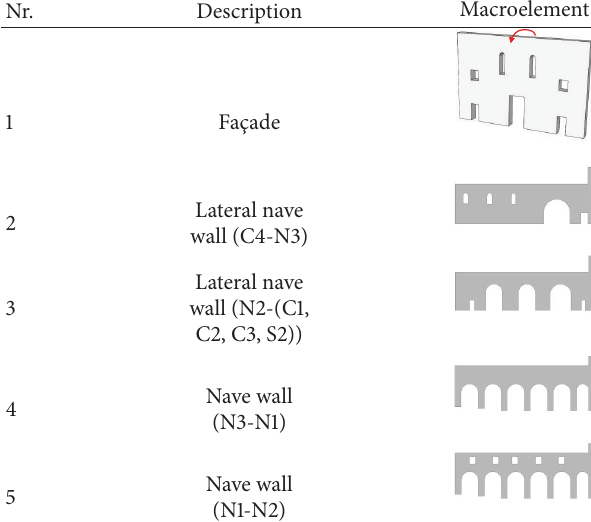
Table 2: Main macroelements